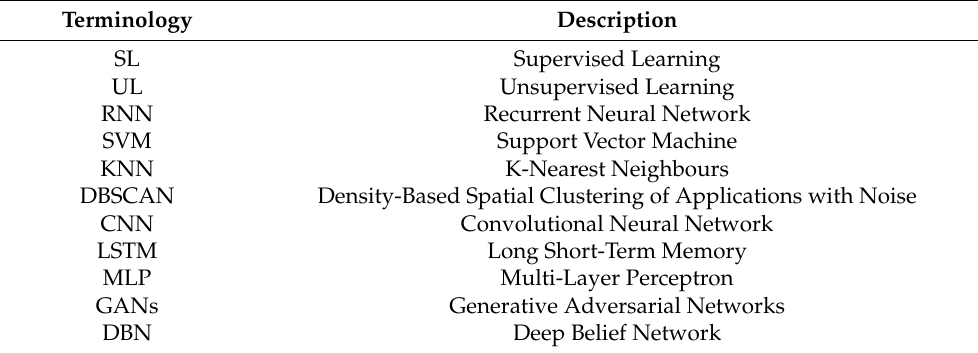
Table 1. List of Terminologies and